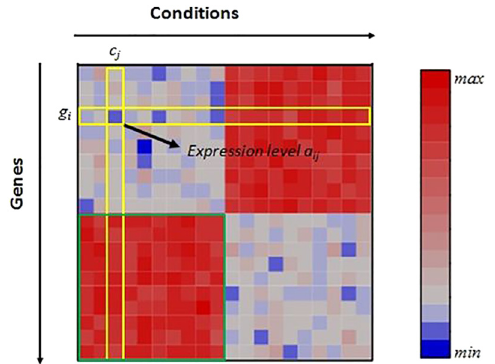
corresponding to ij